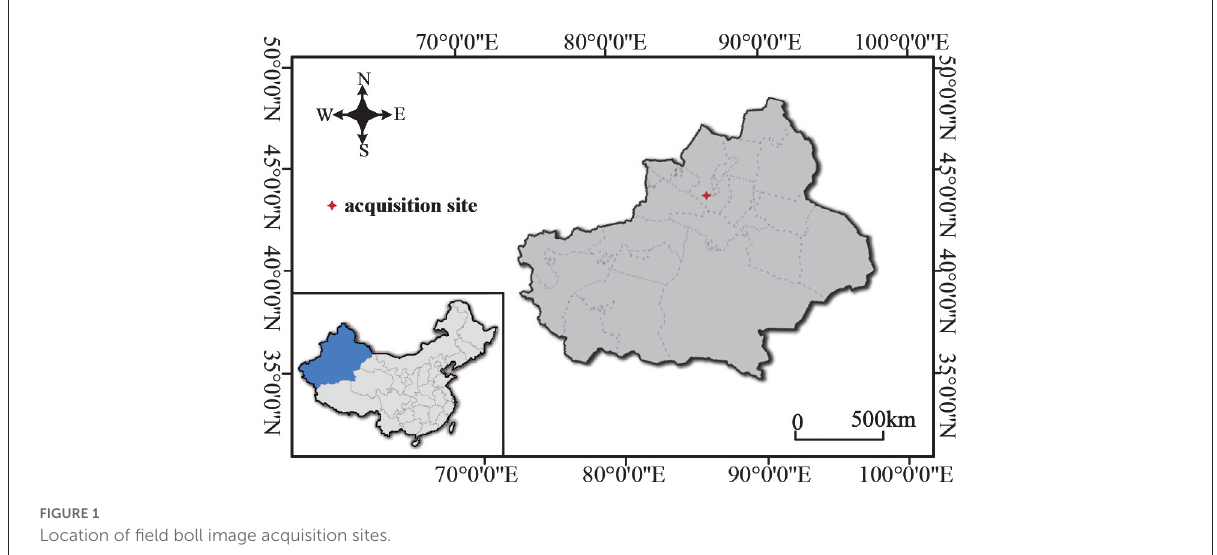
FIGURE1 Location of field boll image acquisition sites.